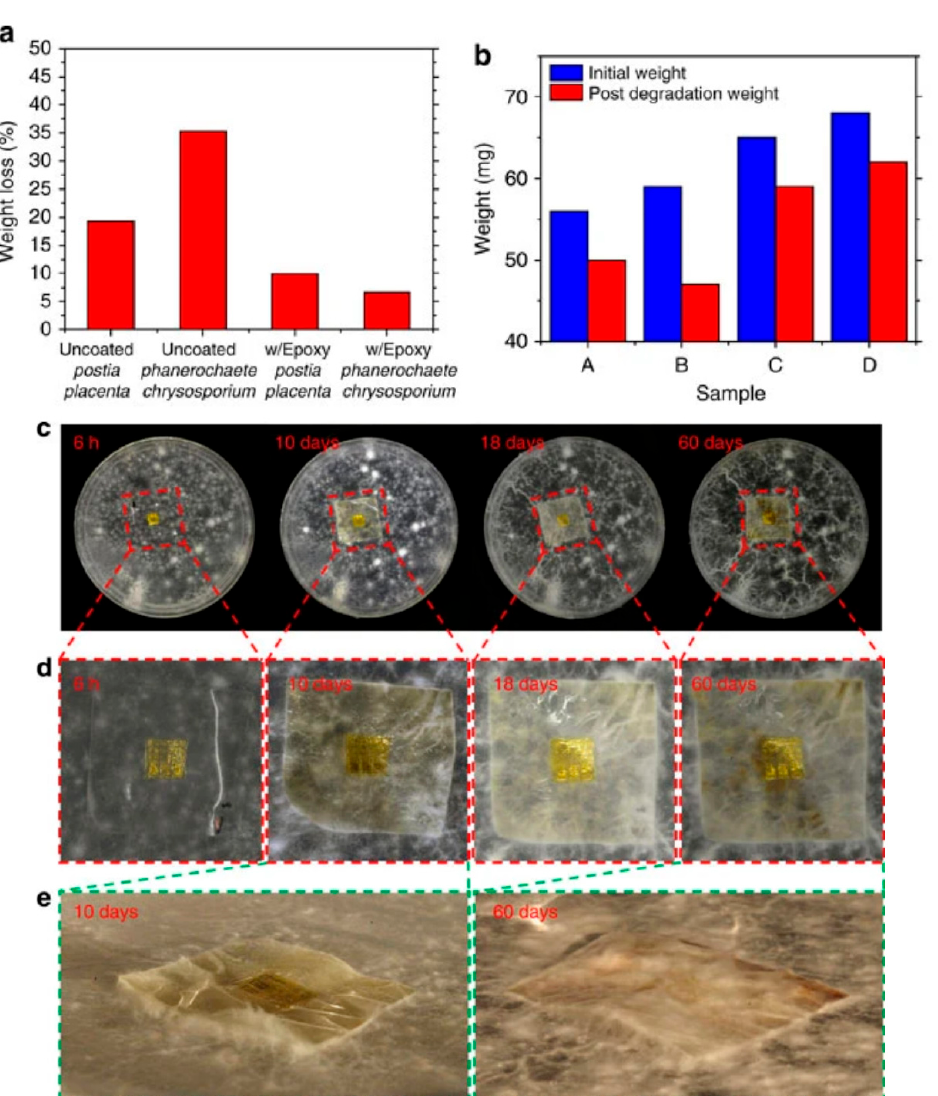
Figure 3. ( a ) Biodegradation tests of two types of CNF films upon addition of two kinds of fungi: left, bare CNF, and right, epoxy-protected CNF. ( b ) Weight loss upon fungal biodegradation of four different electronic devices printed on epoxy-coated CNF. ( c ) Degradation process photographed after 6 h, 10 days, 18 days and 60 days; ( d ) corresponding magnified pictures, and ( e ) magnified and tilted views of the CNF-based device after 10 days and 60 days. Adapted from [50] under a Creative